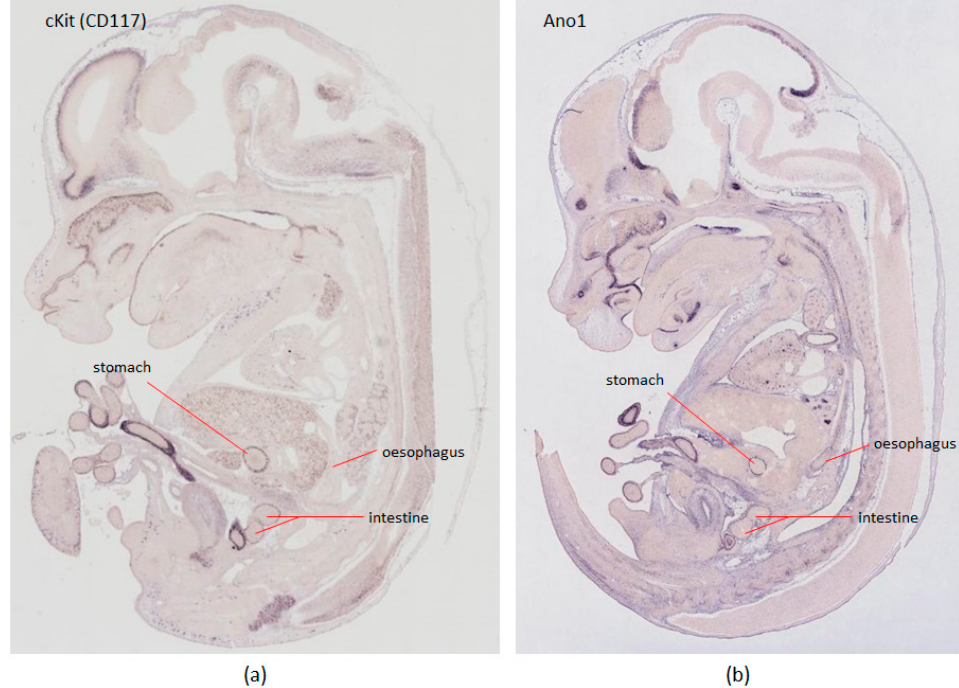
Figure 2. In situ hybridisation of Kit and Ano1 genes in GenePaint [63]. The expression pattern of candidate genes in E14.5 mouse embryos was searched in the GenePaint database and compared. ( a ) cKit oncogene (GPID: MH1718) show moderate expression in gastrointestinal organs; ( b ) Gene Ano1 (GPID: MH710) shows strong expression within gastrointestinal organs, including the oesophagus. GPID: GenePaint Set ID.